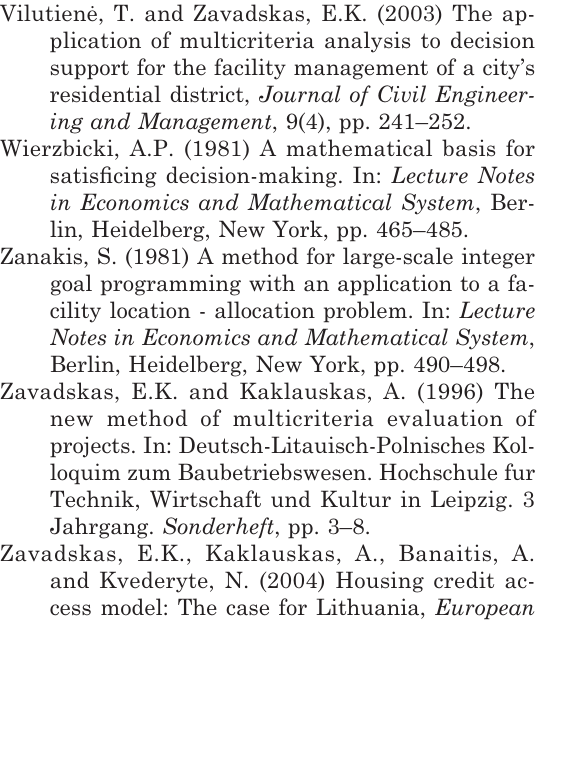
išspręsti buvo naudoti penkiolikos daugiabučius namus administruojančių įmonių paslaugų rodikliai. Įmonės pagal 44 juos apibūdinančius kriterijus vertino daugiabučių namų gyventojai. Pradiniai kokybinių rodiklių reikšmingumai nustatyti taikant ekspertinį metodą. Kokybinių ir kiekybinių rodiklių reikšmingumai sude- rinti, optimalus variantas ir variantų naudingumai nustatyti daugiakriterinio kompleksinio proporcingo ver- tinimo metodu (angl. method of COmplex PRoportional ASsessment, COPRAS ). Pagal taikytą metodą derybų metu galima koreguoti pasiūlymų kainas, atsižvelgiant į nustatytą alternatyvų naudingumą. Daugiakriterinė analizė leidžia nustatyti konkretaus rangovo rodiklių reikšmingumus, įvertinus skirtingus daugiabučių namų priežiūros proceso dalyvių